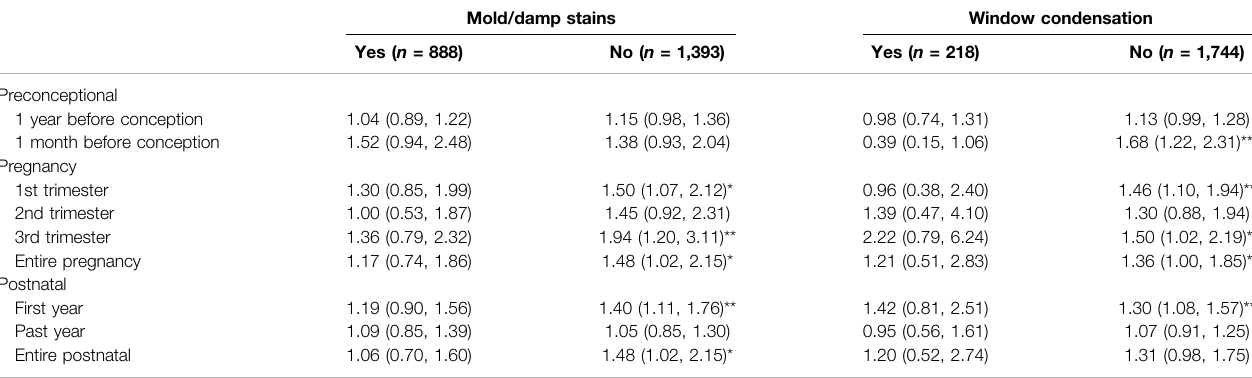
TABLE 6 | Odds ratio of laryngitis due to being exposed to outdoor SO 2 exposure within various time windows strati fi ed by indoor environmental factors that include indoor mold/damp stains as well as window condensation ( n = 2,328). Mold/damp stains Window condensation